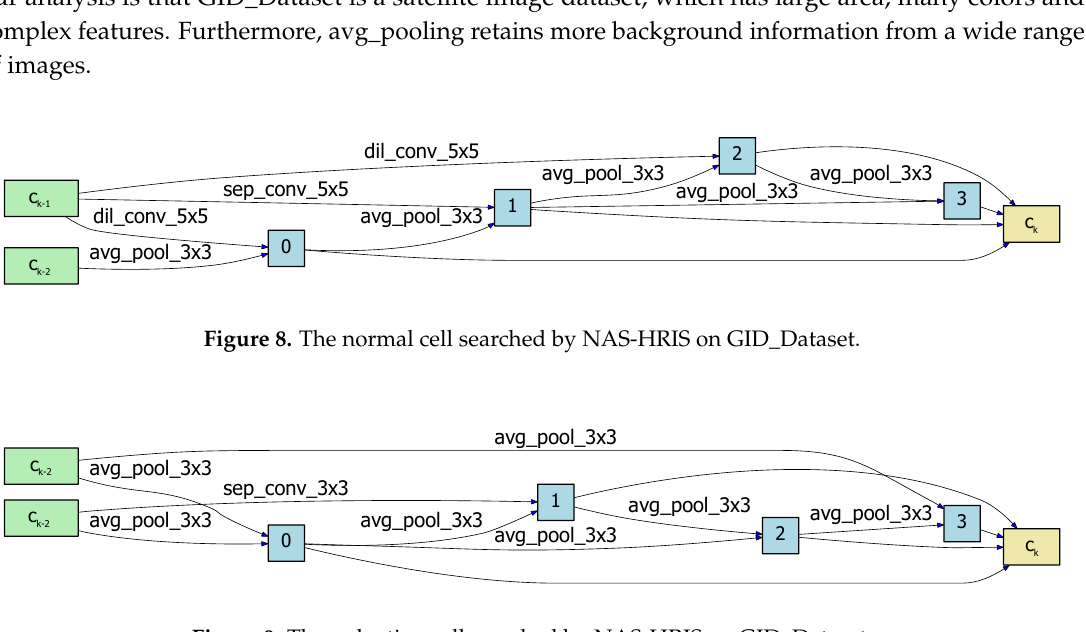
Figure 9. The reduction cell searched by NAS-HRIS on